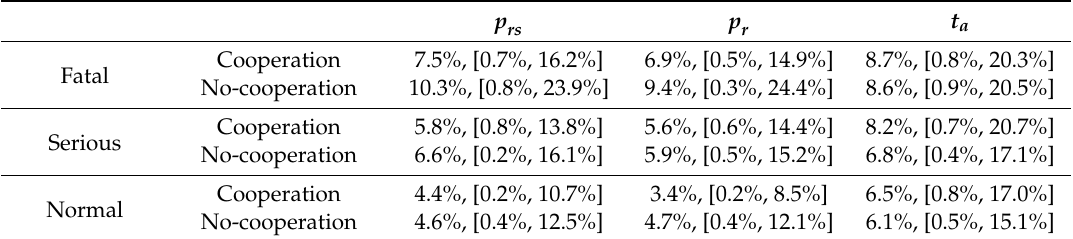
Table 5. The relative error of three indicators in three